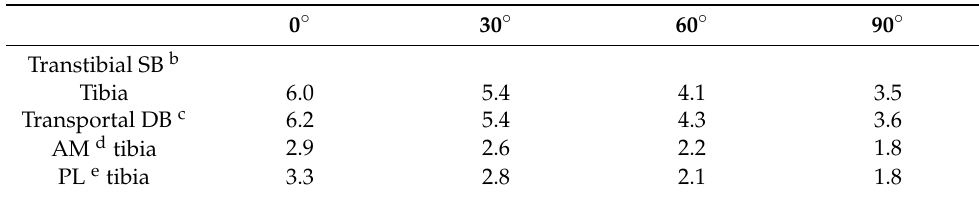
Table 3. Contact stress between tibial tunnel and graft during knee flexion combined with a 134 N anterior load.